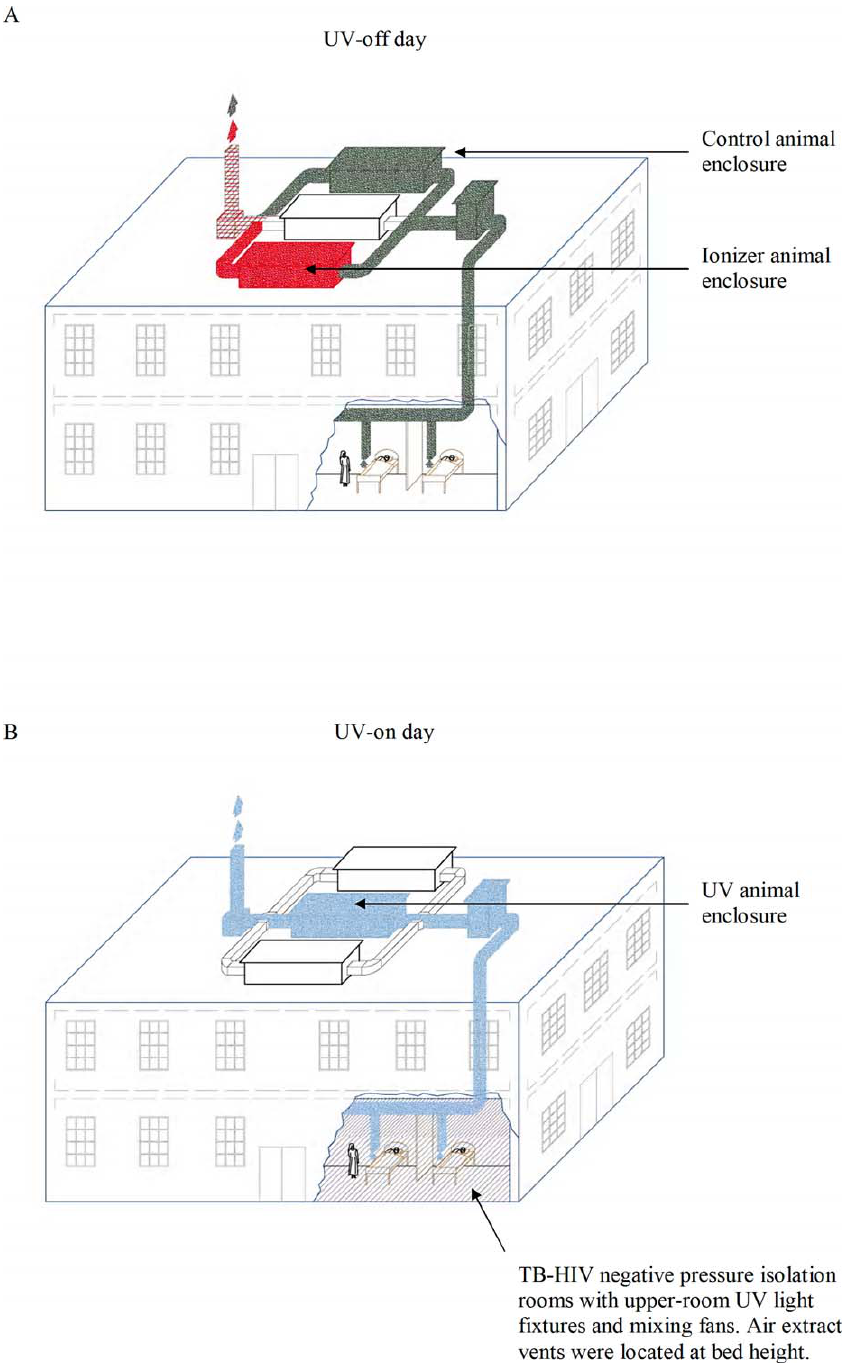
Figure 2. Schematic of the Airborne TB Transmission Study Facility on the Roof of an HIV-TB Ward in Lima, Peru´ All exhaust air from the four patient isolation rooms passed over the guinea pigs, housed in groups of up to 150 animals in three exposure chambers: Control group (green); UV lights group (blue); and Ionizer group (red). Guinea pigs were exposed on alternate days to ward air or fresh outside air, according to the rotation below, with a 45-min wash-out period between study days. (A) UV-off day (Control day): No air cleaning intervention on the ward. Exhaust air from the ward was divided on the roof, half passing through the Control enclosure of guinea pigs, and half passing through the Ionizer enclosure, inside which were located three large space negative air ionizers (ESCSs). On these days, fresh outside air was passed through the centrally positioned UV lights group exposure chamber. (B) UV-on day: UV lights and mixing fans were turned on in the ward. Half of the ward air passed through the UV lights group animal enclosure, and half was sterilised and exhausted into the atmosphere. The other two exposure chambers were ventilated with fresh outside air.